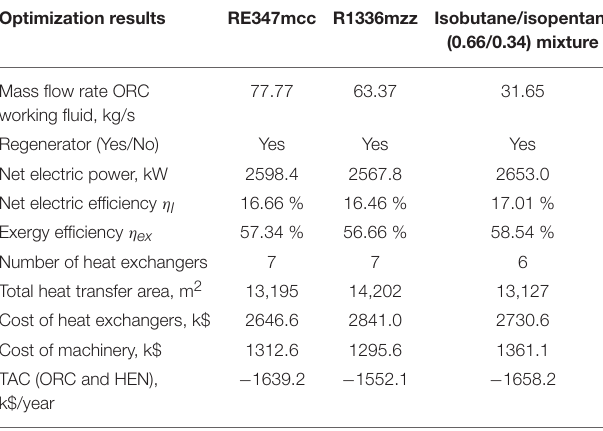
TABLE 6 | Results of the techno-economic optimization for the high electricity price scenario (140 $/MWh). Optimization